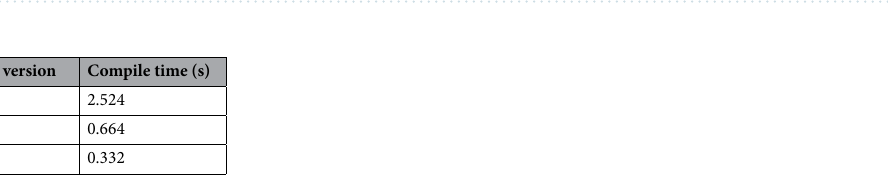
Table 3. Compilation time versus different gcc package versions used to test the present